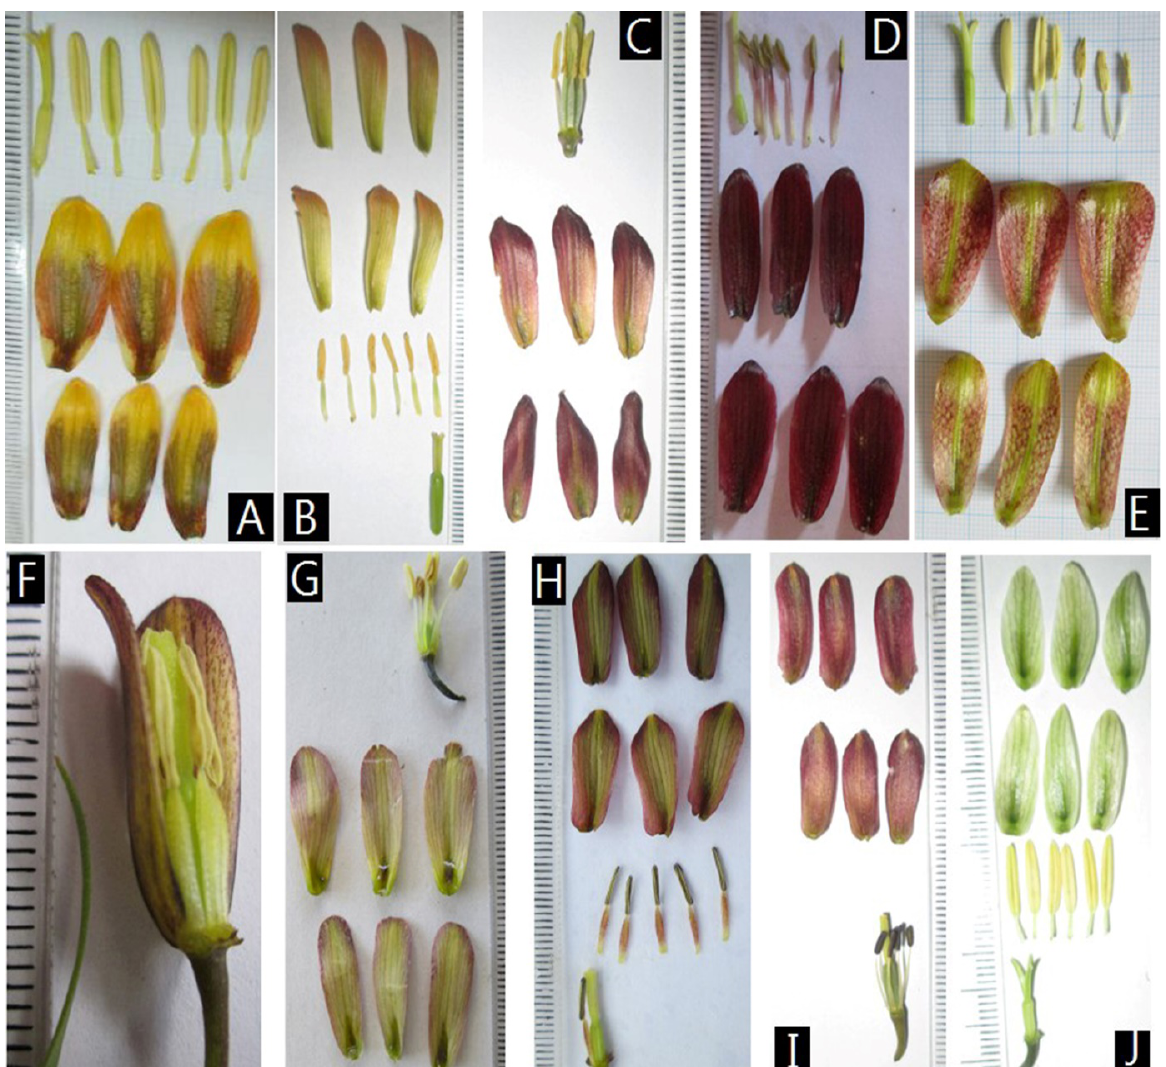
Fig. 1. Flower parts in studied Fritillaria species. Specimen and character lists are presented in Tables 1, 2. A: F. reuteri , B: F. chlorantha , C: F. assyriaca , D: F. caucasica , E: F. crassifolia ssp. kurdica , F: F. uva-vulpis , G: F. persica , H: F. pinardii , I: F. zagrica , J: F.